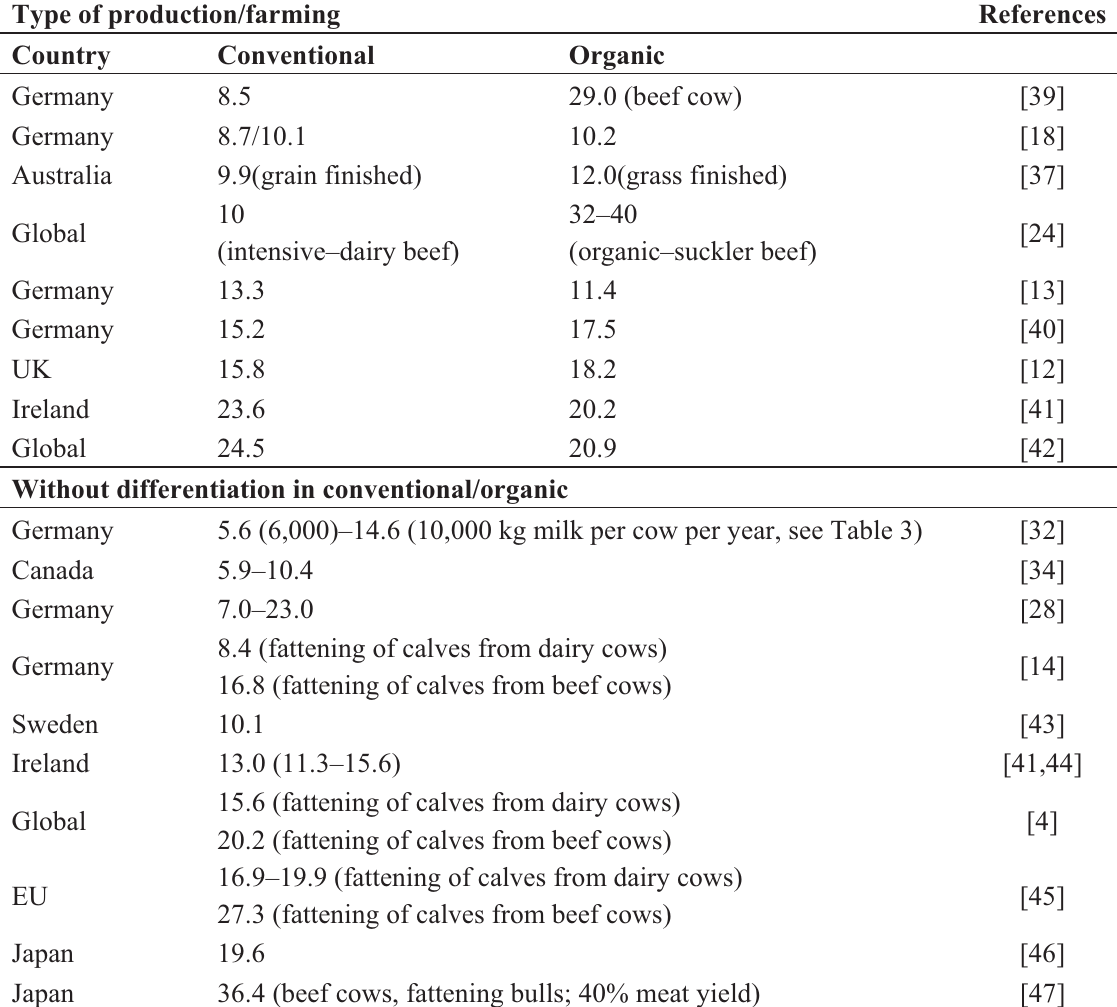
Table 2. Examples for CF (kg CO type of